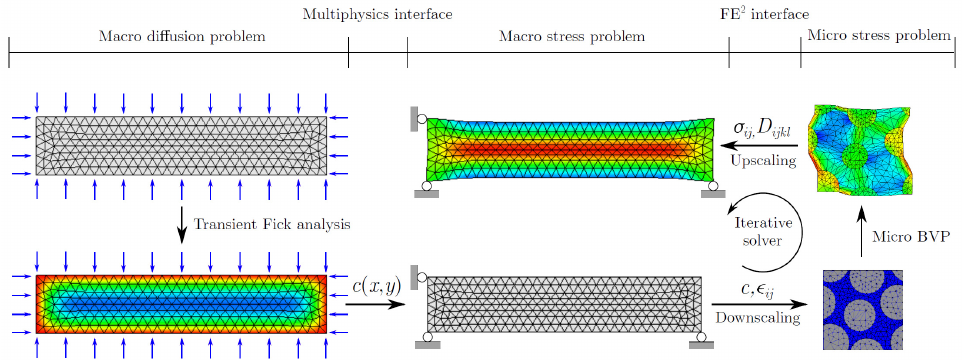
Figure 8. Examples of Representative Volume Elements (RVE) used in different studies [112,202,210].